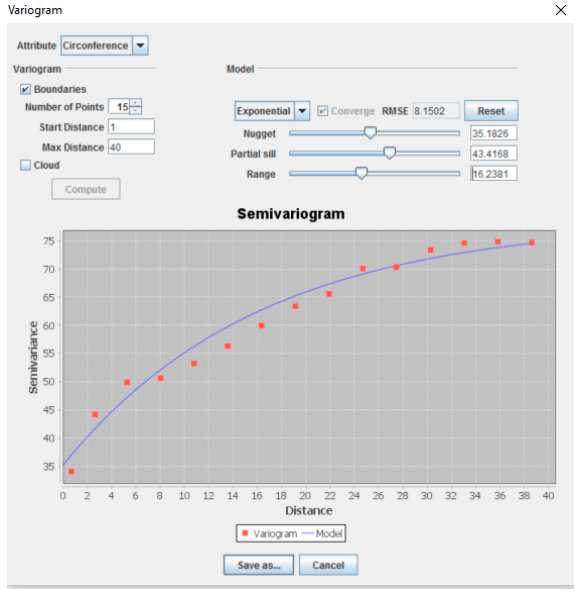
Figure 4. Screenshot from GeoFIS illustrating the calculation of the experimental variogram and the fitting of a theoretical variogram model to the within-field pseudostem circumference spatial data.